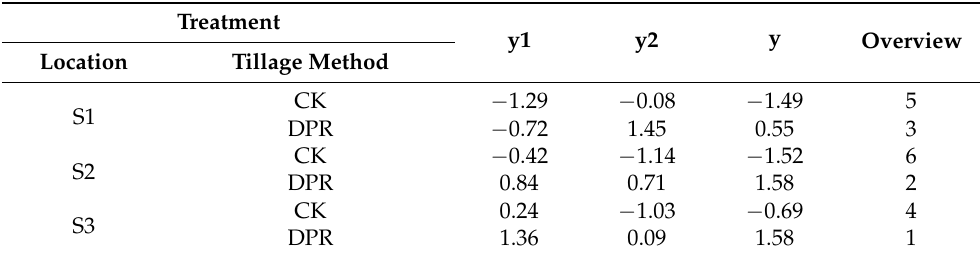
Table 8. Principal component scores and comprehensive evaluation of each index under different degrees of salinity.